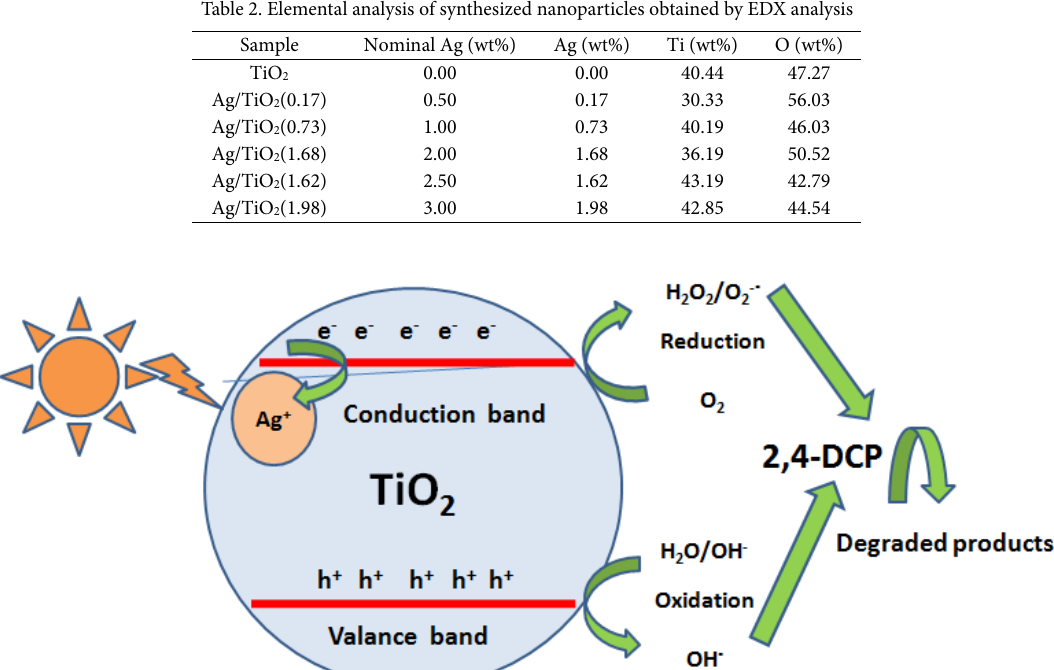
Fig. 5. Our proposed mechanism for photocatalytic degradation of 2,4-DCP Figure 5. Our proposed mechanism for photocatalytic degradation of 2,4-DCP.